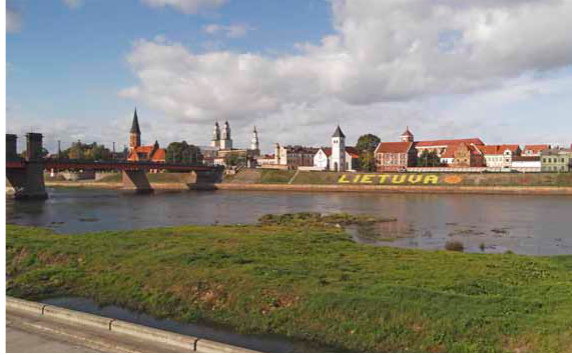
fig. 9. The formation of King Mindaugas avenue with the multi-storey garage complex in Kaunas at the beginning of the 21st century. a completely unattractive riverside area was created in the city centre. l. Dringelis